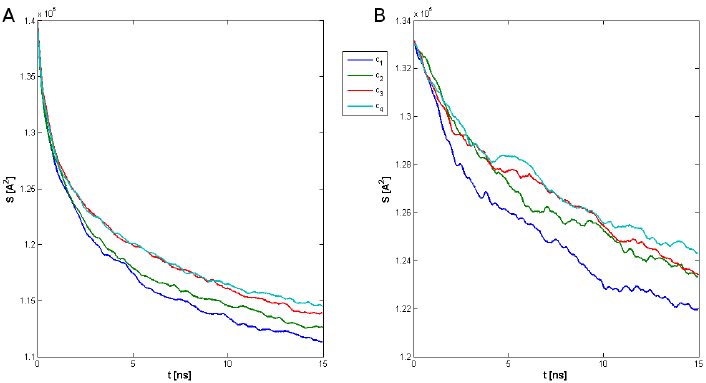
Figure 9. Solvent accessible surface of HA networks: ( A ) inter-molecular networks are depicted; and ( B ) intra-molecular networks.